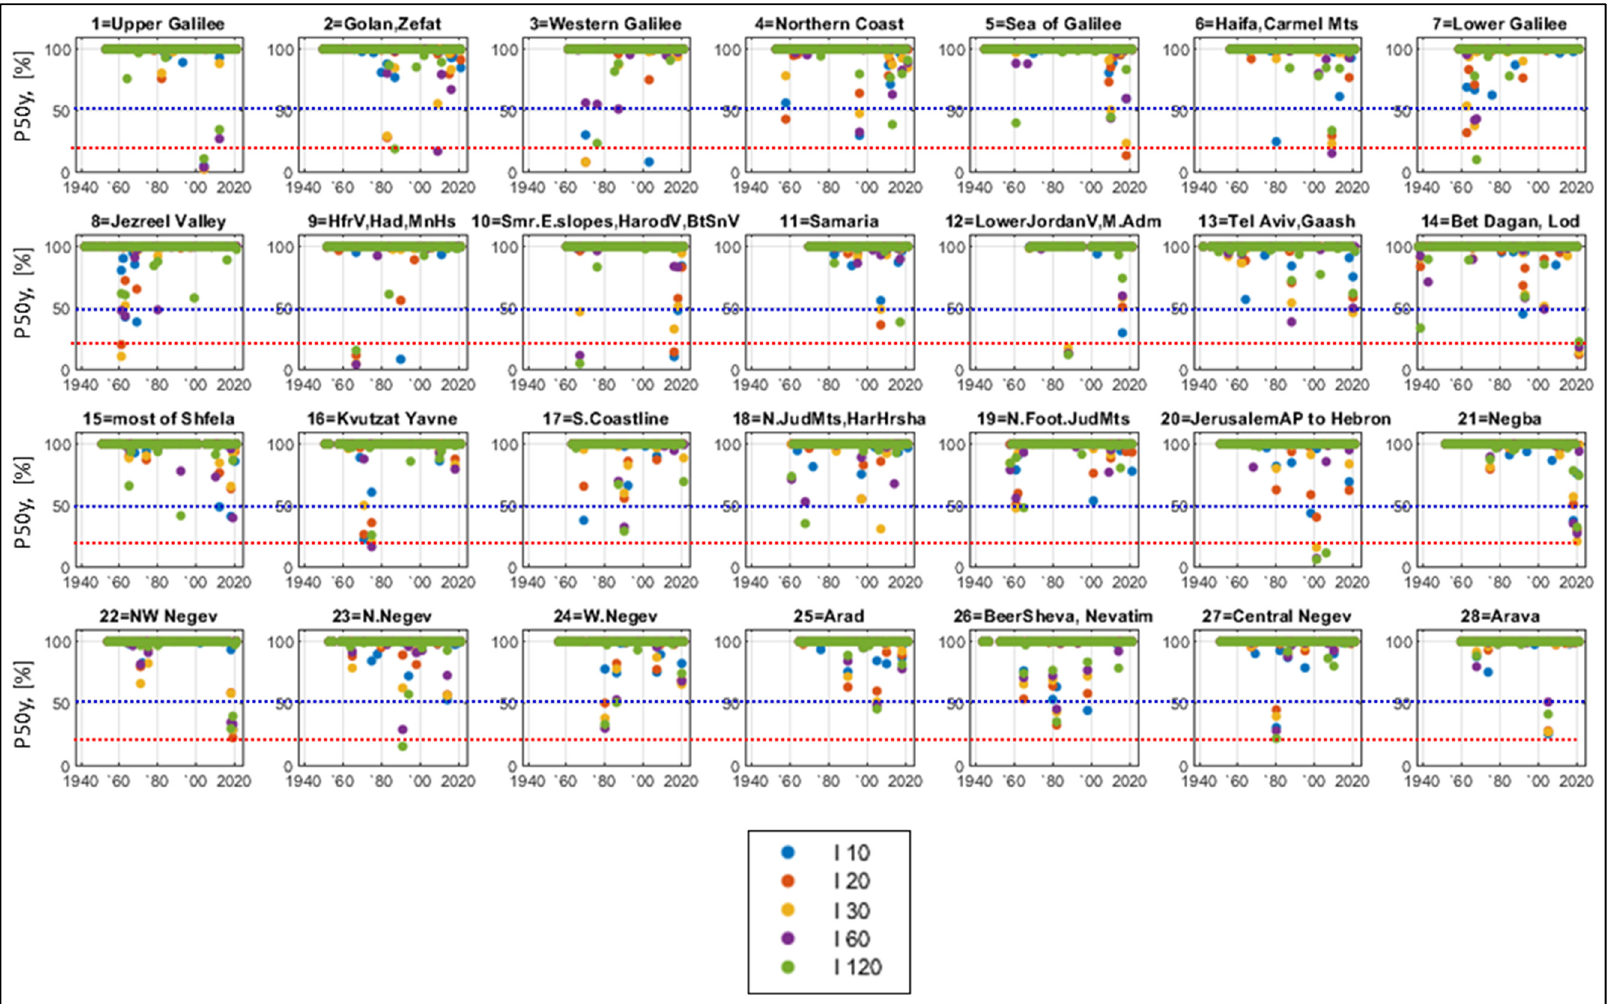
Figure 8. The 50-year exceedance probabilities. Blue lines denote P 50y = 50% corresponding to return periods longer than 72 years, while red lines— P 50y = 20% corresponding to return periods longer than 225 years. All the 50-year probabilities were calculated using Formula (4c) after substitutions: P 50y = 1 − (1 − 1/ T )50.